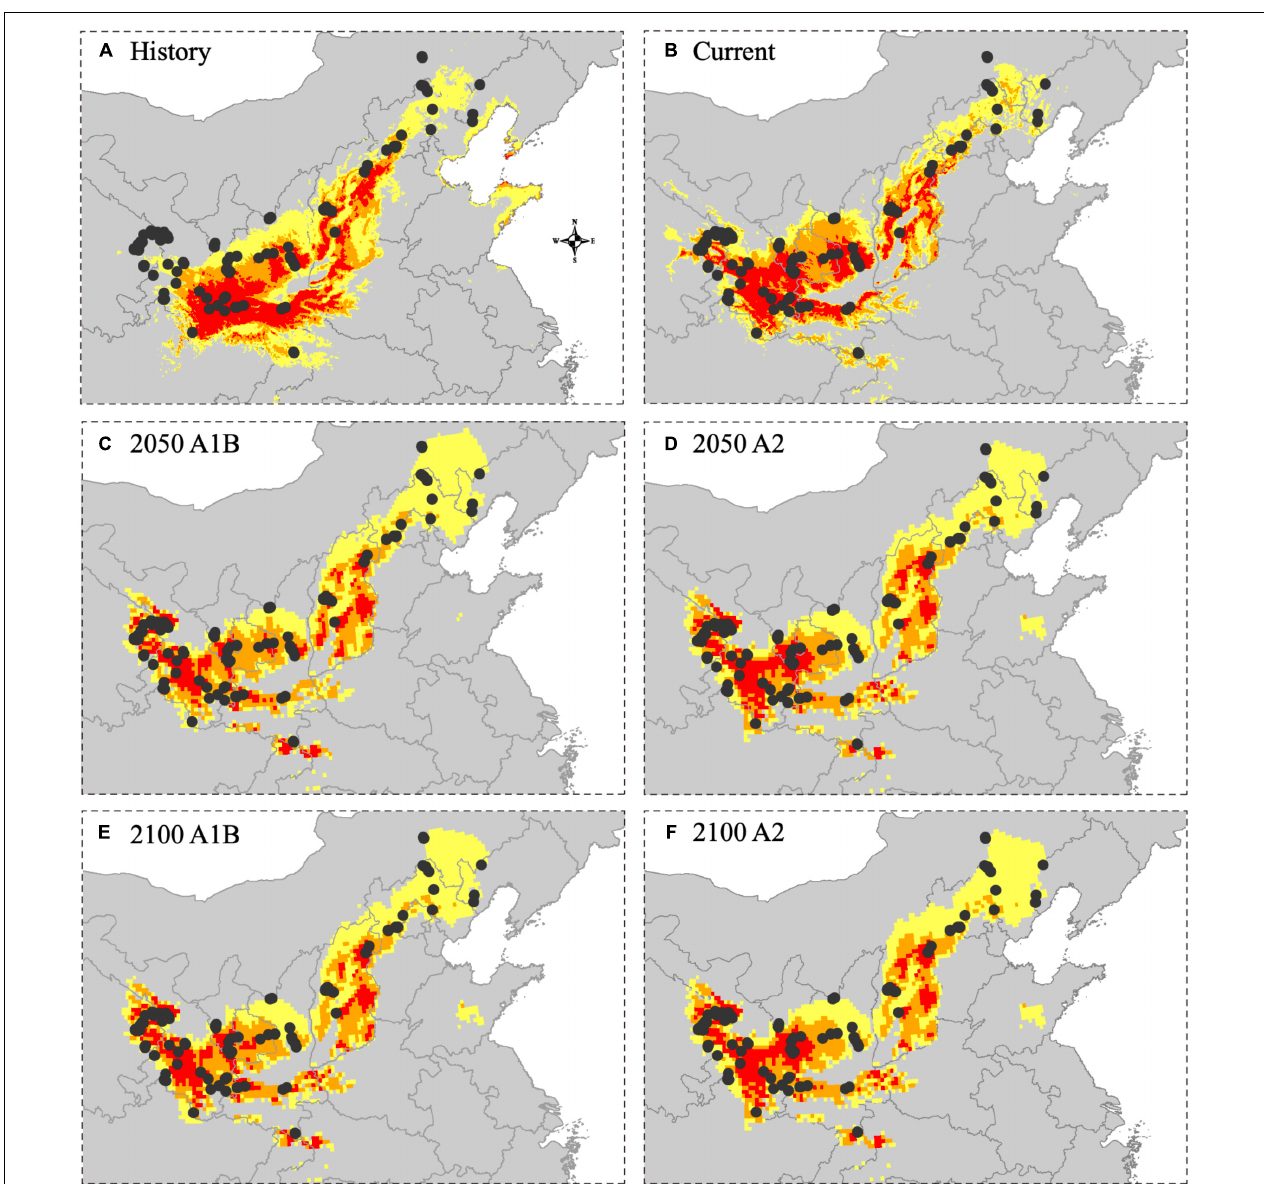
FIGURE 6 | The fitting degree of 2019 sample sites and predicted distribution in different time periods. (A) The overlap between 2019 sample sites and historical distribution (1905–2000). (B) The overlap between 2019 sample sites and current distribution (2000–2016). (C) The overlap between 2019 sample sites and future distribution (2050 A1B SRES scenarios). (D) The overlap between 2019 sample sites and future distribution (2050 A2 SRES scenarios). (E) The overlap between 2019 sample sites and future distribution (2100 A1B SRES scenarios). (F) The overlap between 2019 sample sites and future distribution (2100 A2 SRES scenarios).